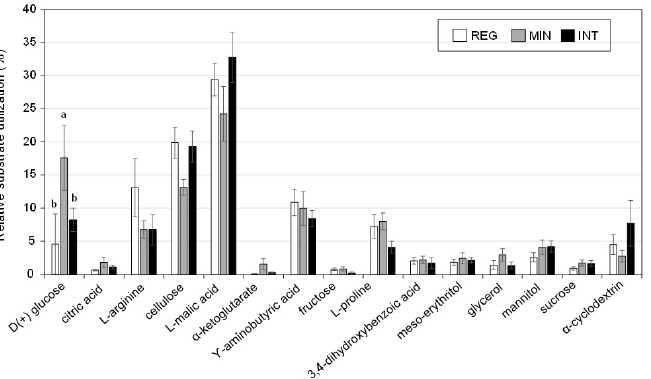
Figure 3. Respiration profiles of the soil microbial communities in the three vineyards studied in this work under intensive management (INT), regenerative management (REG), and minimum impact management (MIN). Mean ± standard error for n = 8. Different letters (a, b) indicate significant differences between treatments after ANOVA. PERMANOVA indicated significant differences between the microbial physiological profiles of the three vineyards ( p = 0.0002). Specifically, the intensively managed vineyard differed from the regenerative ( p = 0.002) and from the minimally managed vineyards ( p = 0.0003). The SIMPER analysis showed that D(+) glucose (13.4%) and L-malic acid impact vineyards (the two of them were more exploited in the minimum impact plot), and L-malic acid (15.2%), cellulose (11.1%), g-aminobutyric acid (11.1%), and L-proline (10.2%)